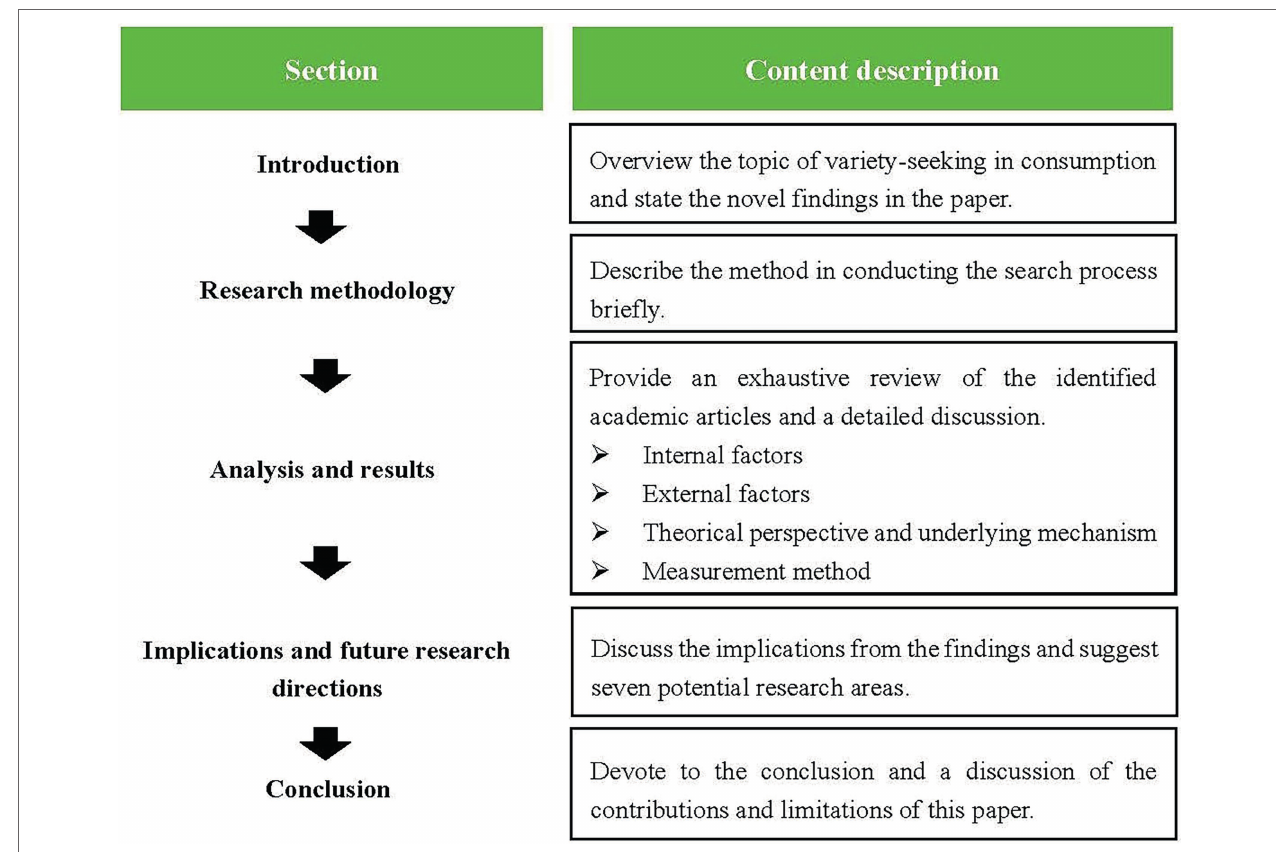
FIGURE 1 | Flow diagram of